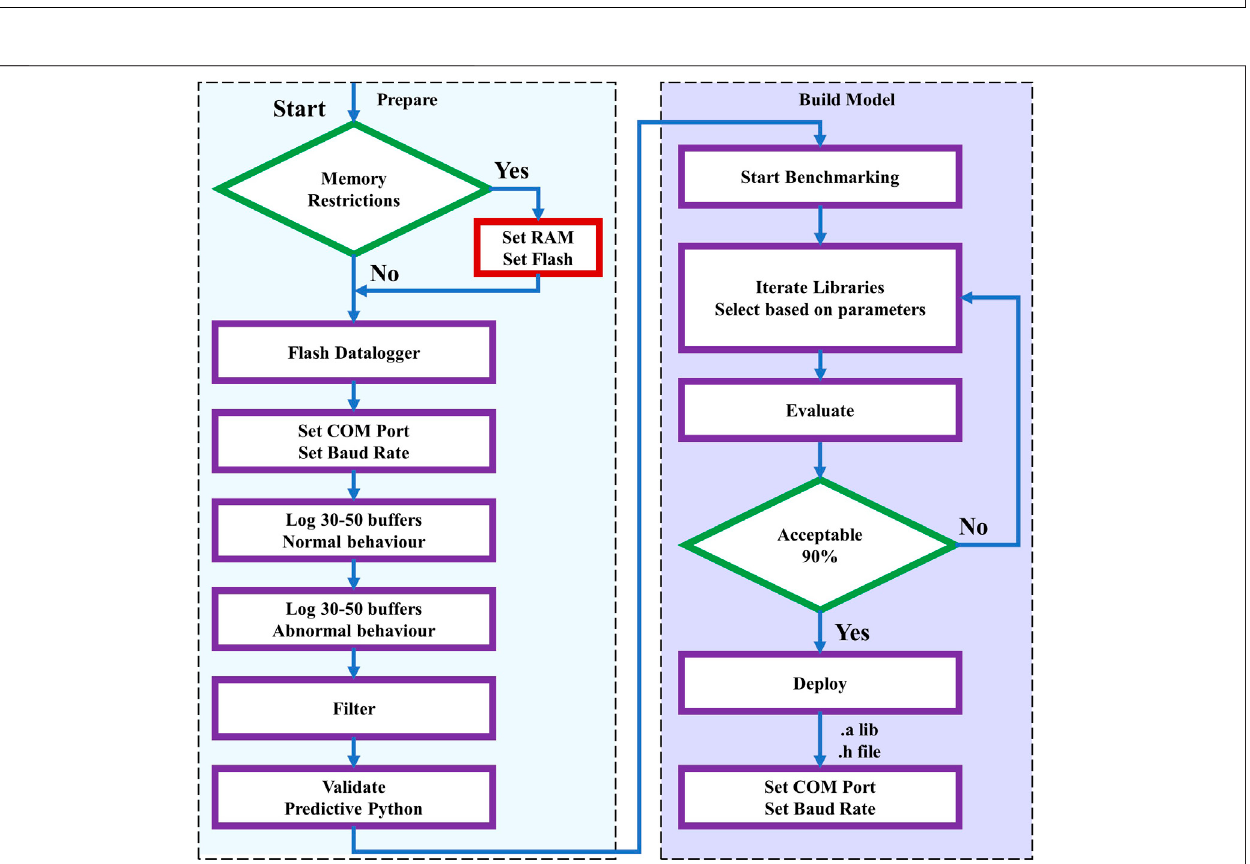
FIGURE 9 | Flow chart for implementation of an AI-based model with NanoEdge AI